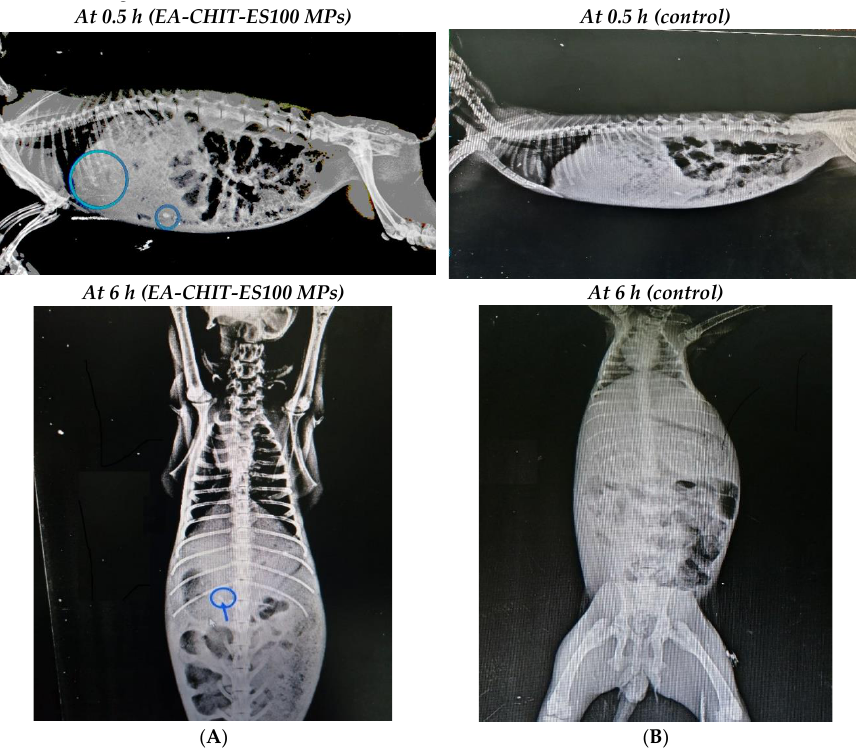
Figure 7. X-ray photographs of ( A ) EA-CHIT-ES100 MPs and ( B ) after 0.5 and 6 h.